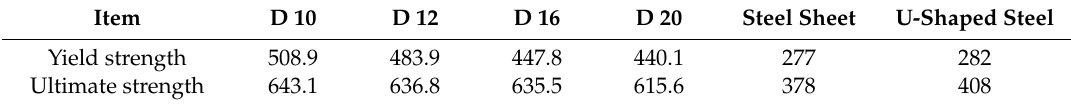
Table 3. Mechanical properties of steel (unit: MPa).